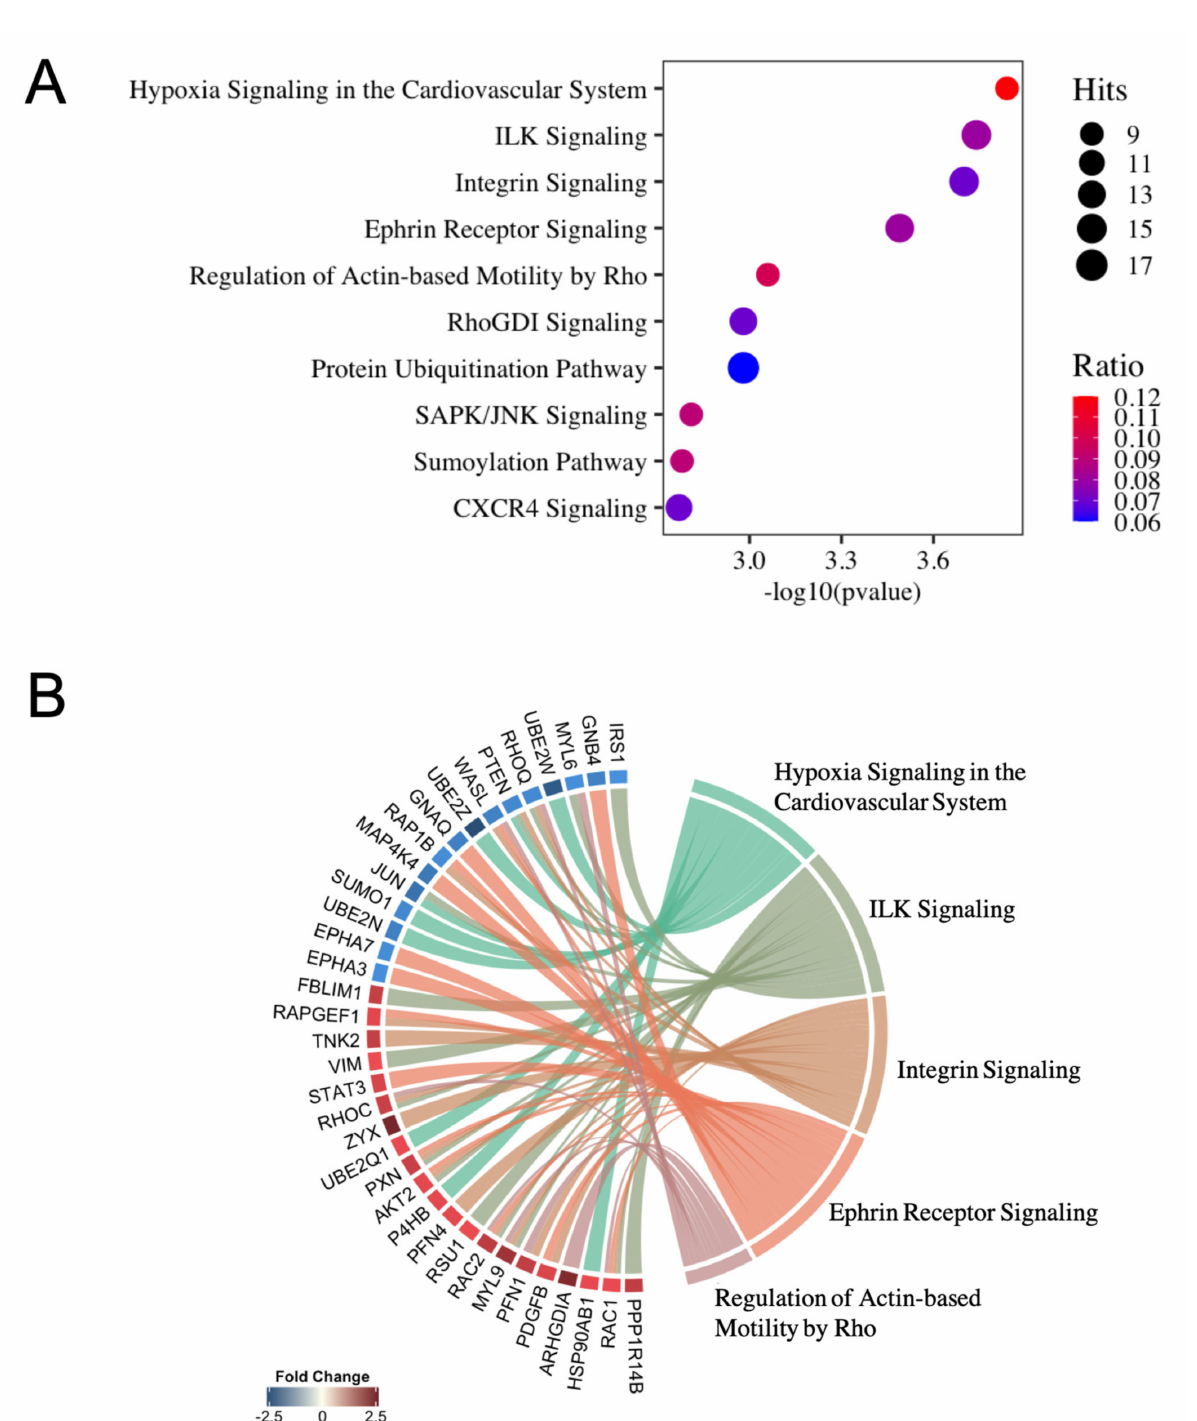
Figure 3. Canonical pathway study of inversely correlated miRNA–mRNA pairs using IPA software. ( A ) High predicted and experimentally observed pairings among inversely correlated miRNA–mRNA interactions were used to determine canonical pathways. p -value is determined by the probability that each biological function assigned to the network is due to chance alone. Hits represent the number of differentially expressed genes regulated per network. Ratio represents the amount of differentially expressed genes obtained in a given pathway divided by total number of genes in a specific canonical pathway. ( B ) Chord plot representing associations between differentially expressed genes and their canonical